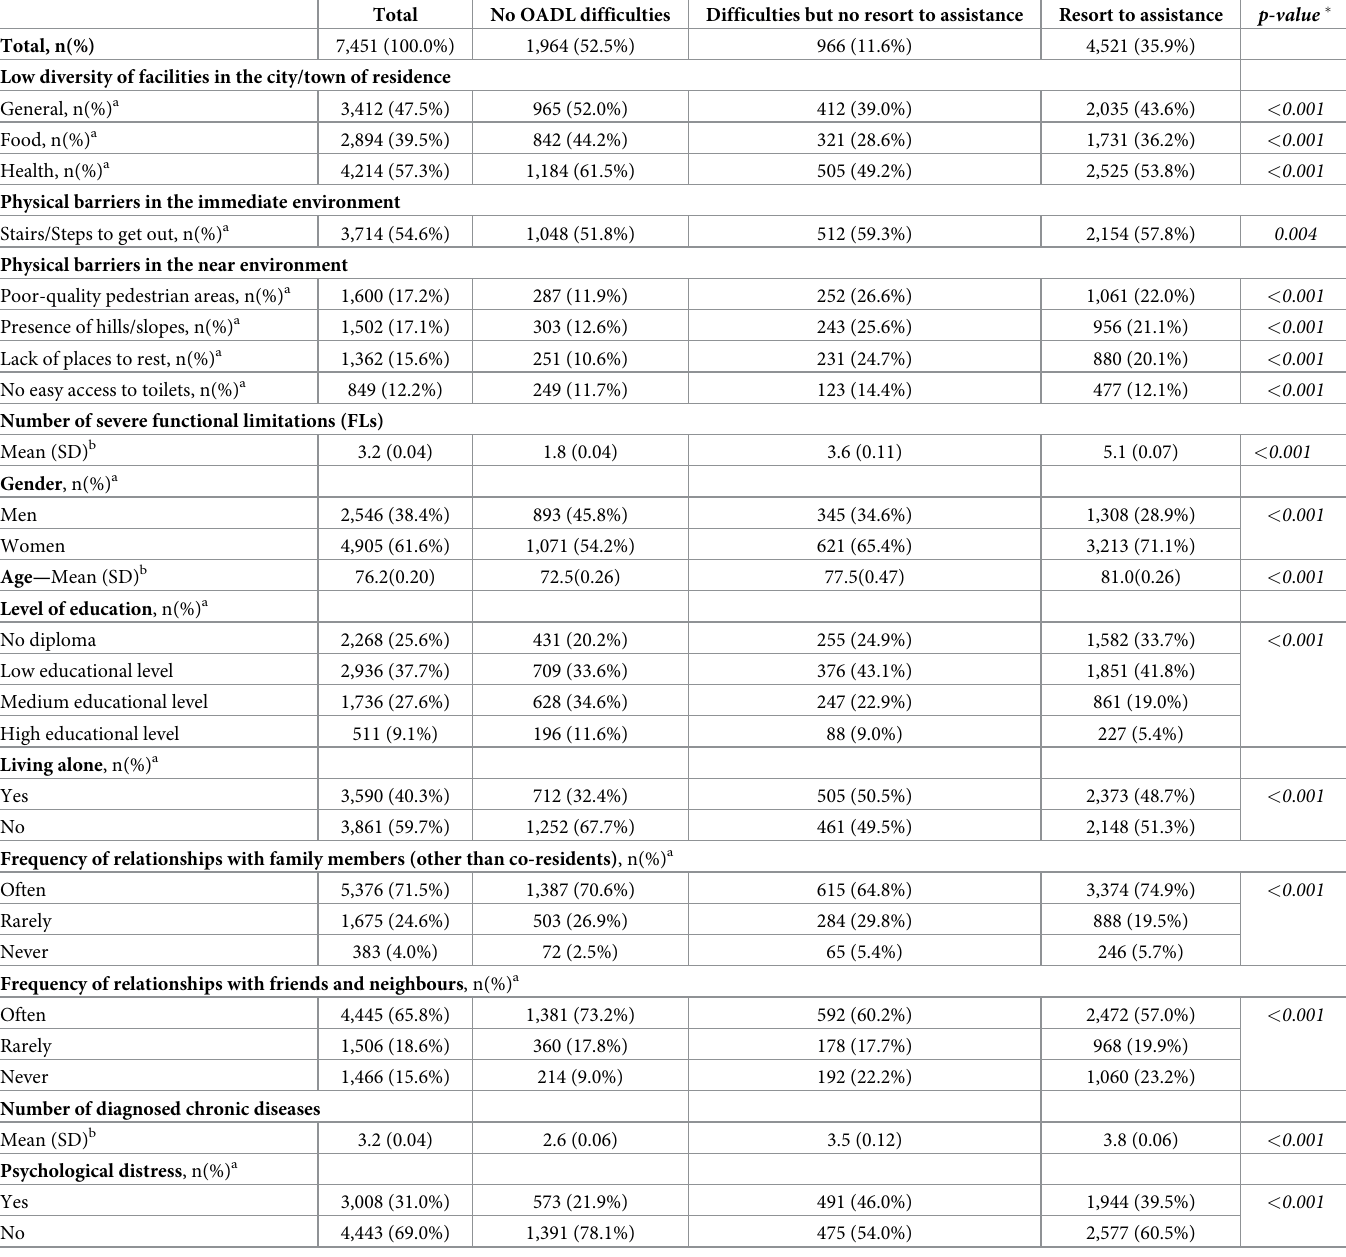
Table 1. General characteristics of the study sample. CARE-Seniors Me´nages Survey (60+ with at least 1 FL), 2015,